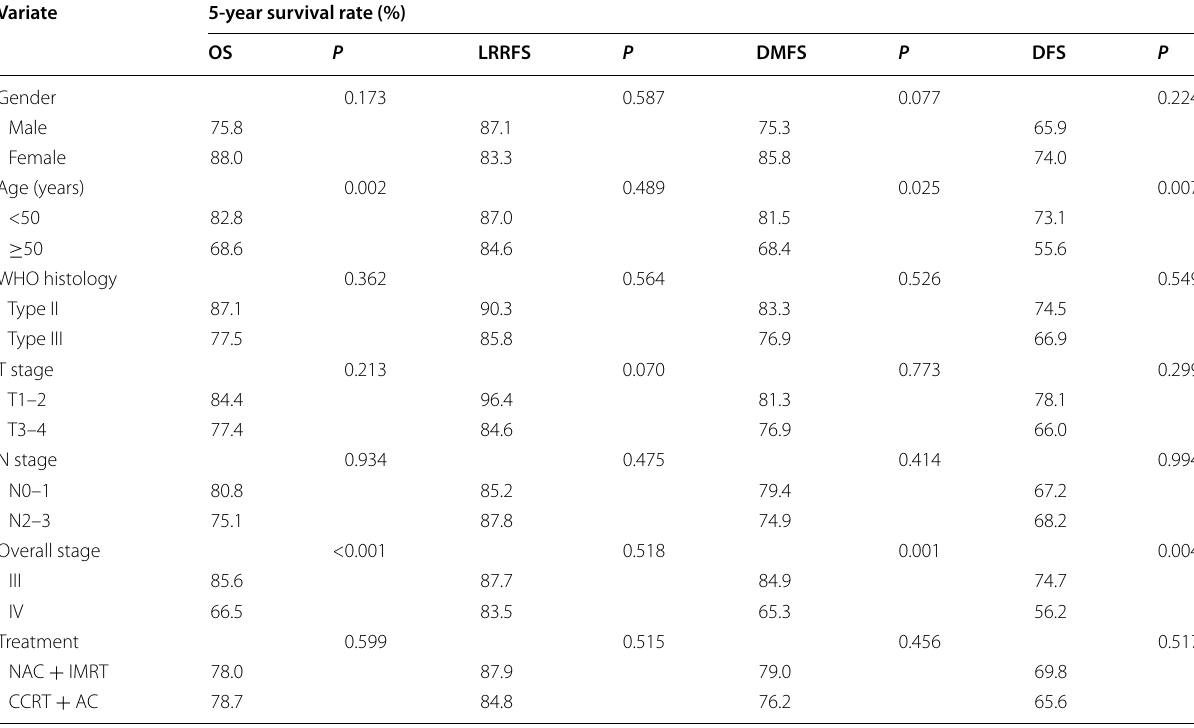
Table 5 Univariate analysis of prognostic factors for patients with locoregionally advanced NPC